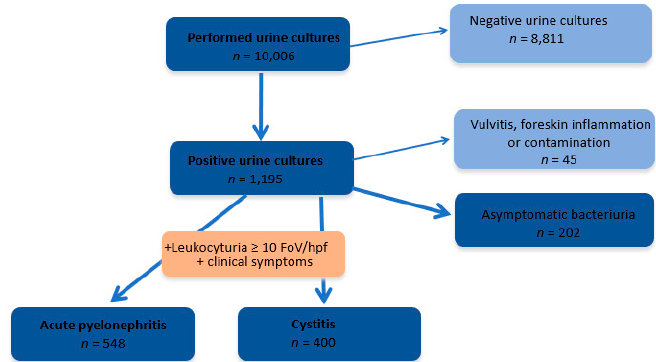
Figure 1. Distribution of urine culture results. Table 1. Demographic data, clinical presentations, and laboratory data in children with